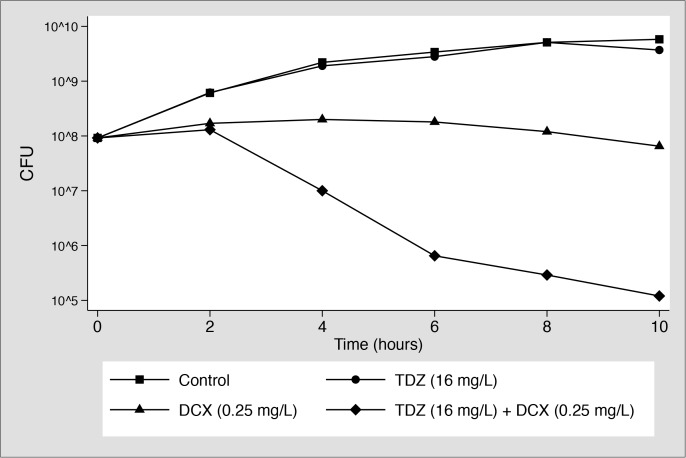
In vitro viability assay: The effect of thioridazine (TDZ) and dicloxacillin (DCX), alone and in combination, on survival of MSSA (ATCC 29213) over time.Control: No drug.